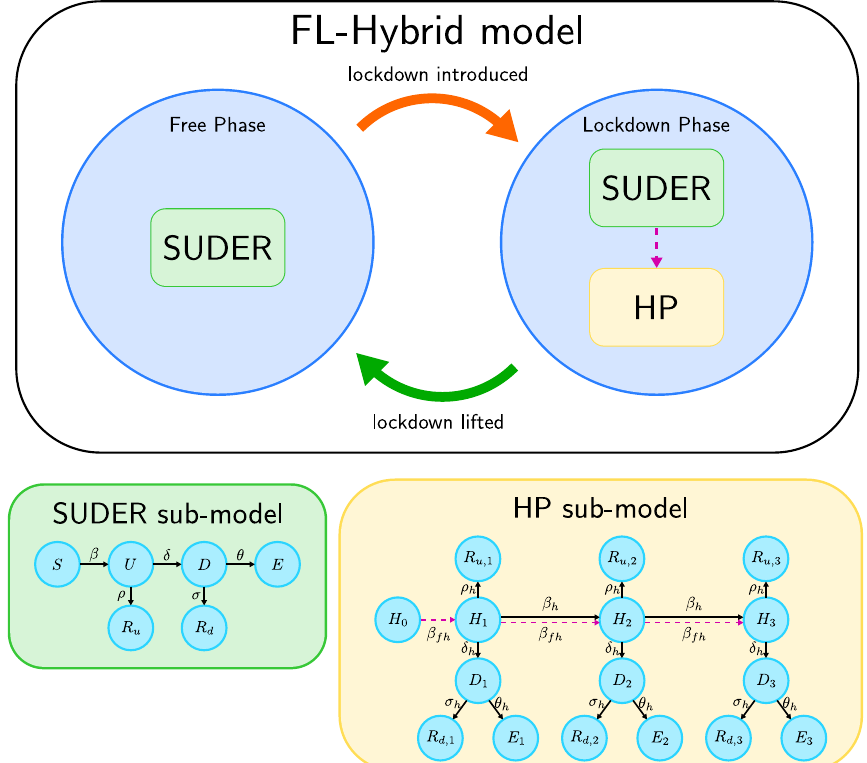
Figure 1. The FL-Hybrid model. Graphical scheme illustrating the switching between the free and lockdown phases of the FL-Hybrid (Free-to-Lockdown Hybrid) model, as well as the interactions between the sub-models operating within them. The SUDER (Susceptible, Undetected or Undiagnosed Infected, Detected or Diagnosed Infected, Extinct and Recovered) sub-model describes the epidemic dynamics within the whole population in the free phase and within the fraction of the population not isolating during a lockdown. The HP (Household Partitions) sub-model describes the epidemic dynamics within the fraction of population isolating in their own household during a lockdown. Specifically, H i denotes the number of households with i undetected infected. The dashed magenta line represents the potential introduction of infections in isolating households from rare but unavoidable external contacts with individuals in the